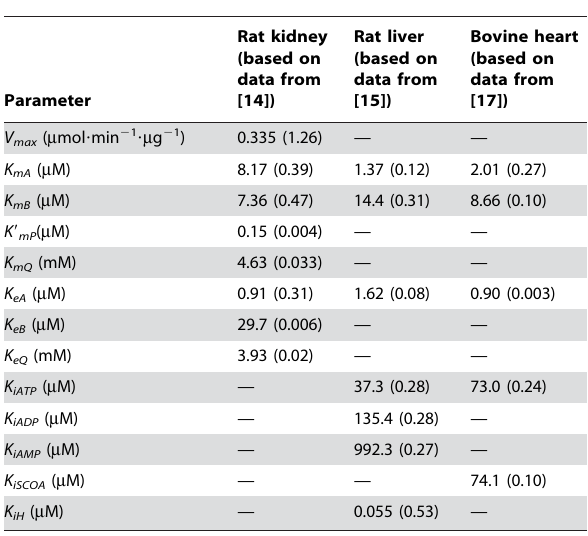
Table 2. Kinetic Parameter Values for Citrate Synthase.